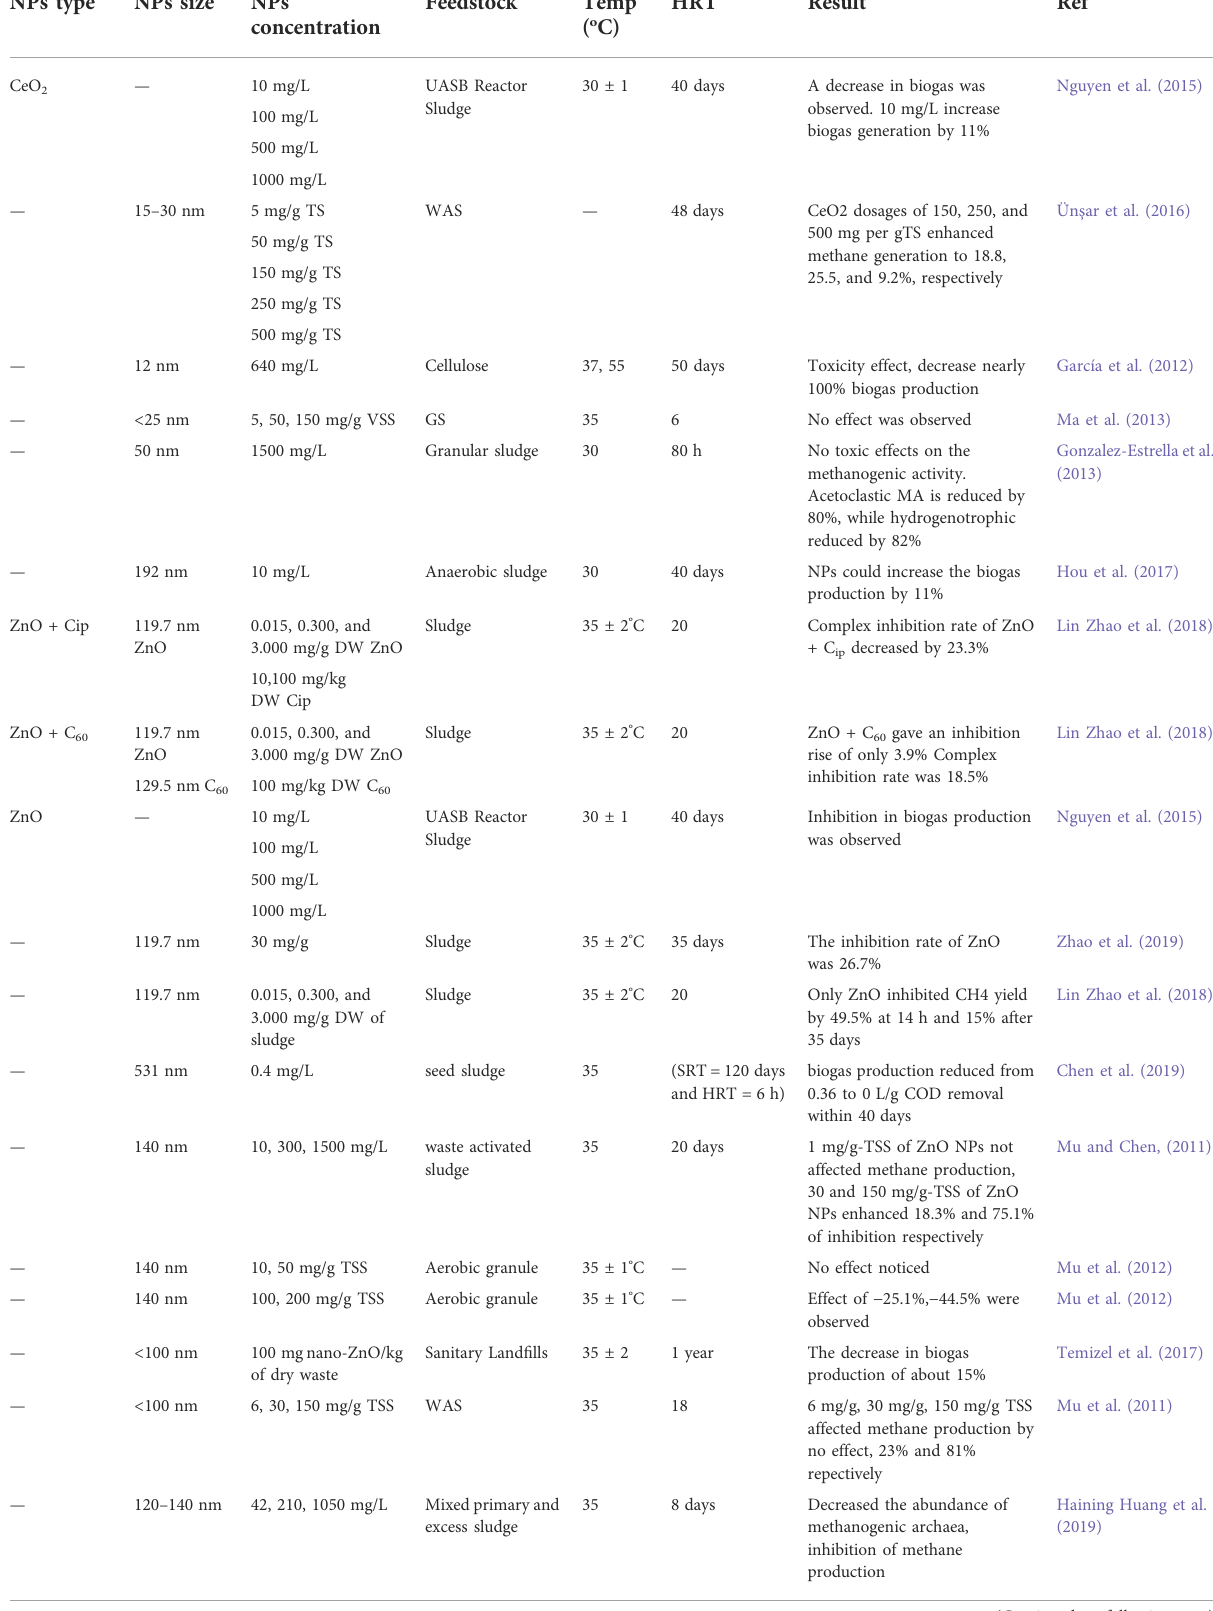
TABLE 3 Reported metal oxide NPs and their in fl uence on biogas